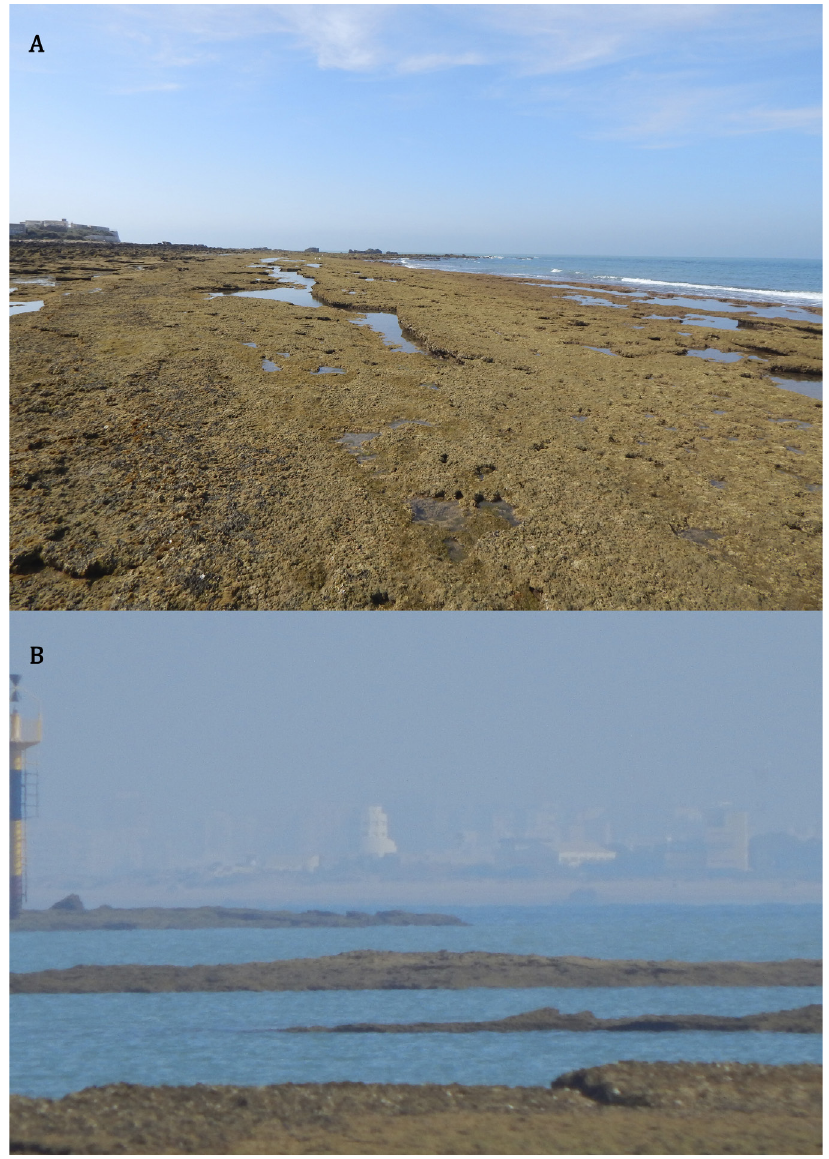
Figure 10. Visibility from Sancti Petri Castle-point 3 (CSP-Arihuela/reef edge). A. Sancti Petri Castle can be observed to the S. B. Camposoto-point 4 can be visualised towards to N.E.